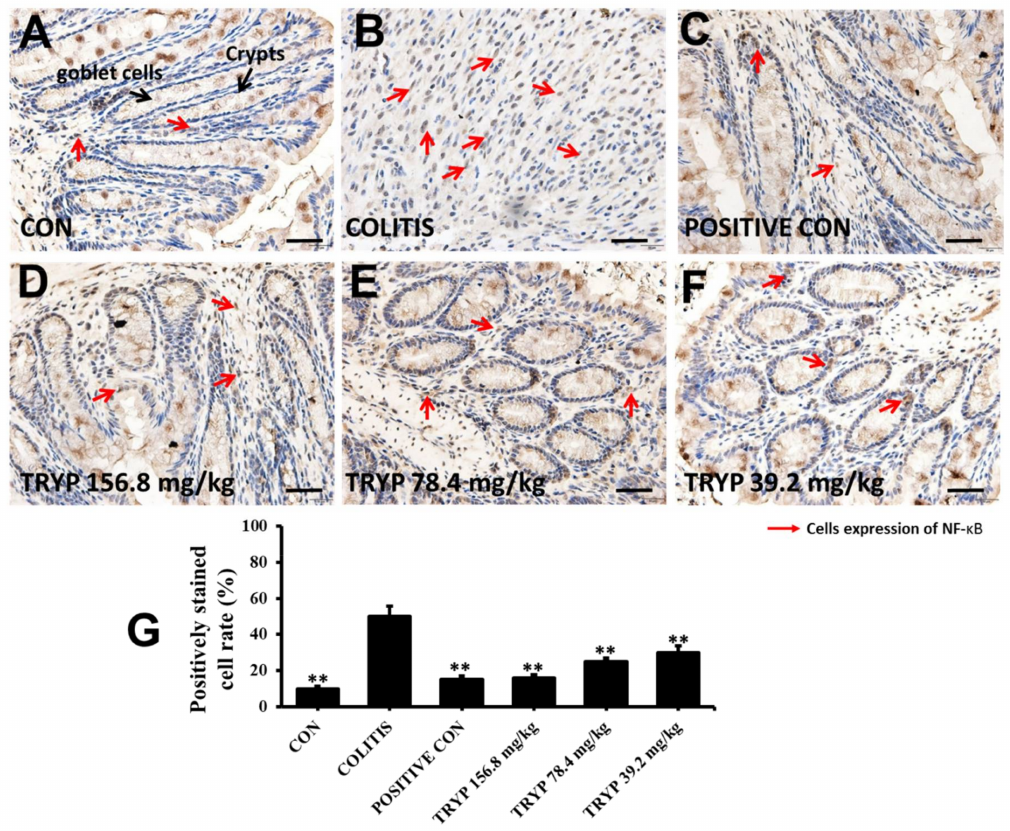
Figure 5. Administration with TRYP inhibited the expression of NF- κ Bp65, magnification × 400. ( A ) Immunohistochemistry result of control group with expressing NF- κ Bp65 barely. ( B ) The expression level of NF- κ Bp65 increased sharply with crypts and goblet cells disappeared. ( C ) Immunohistochemistry result of sulfasalazine control. ( D – F ) The expression level of NF- κ Bp65 with different concentrations of TRYP treatment. ( G ) The column heights represented the positively stained cell rates. Error bars represented means ± SEM of n = 3, ** p < 0.01 compared with colitis. STAT3 was another key signaling molecule that regulates cell circle, apoptosis and